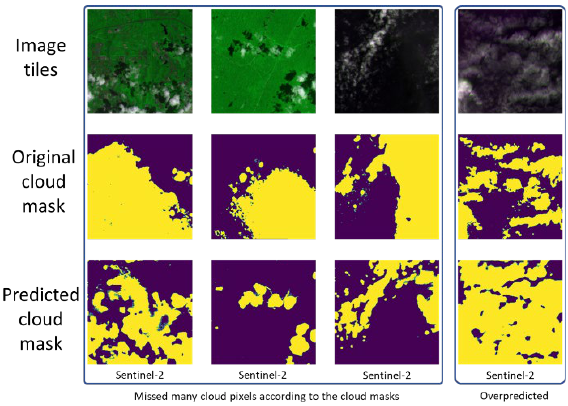
Figure 9. Some randomly selected predicted cloud masks with lower accuracy.